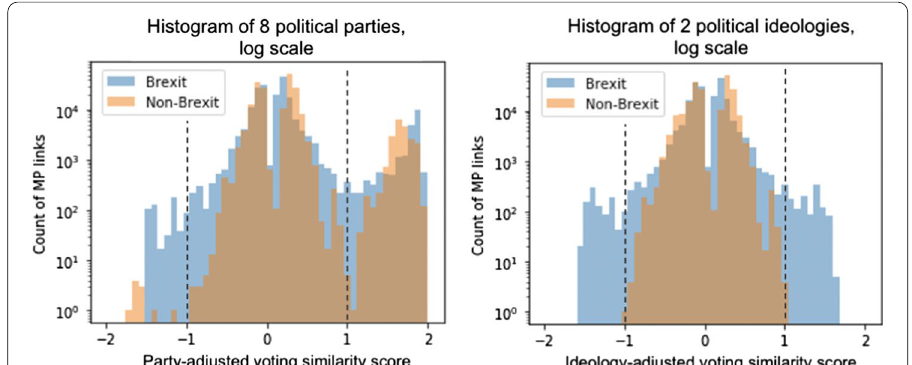
Fig. 1 Histogram of voting similarity scores comparing Brexit and non-Brexit divisions. Left: 8 political parties; Right: 2 ideologies. Values that lie beyond the dotted line close to the extremes represent connections between dissenting